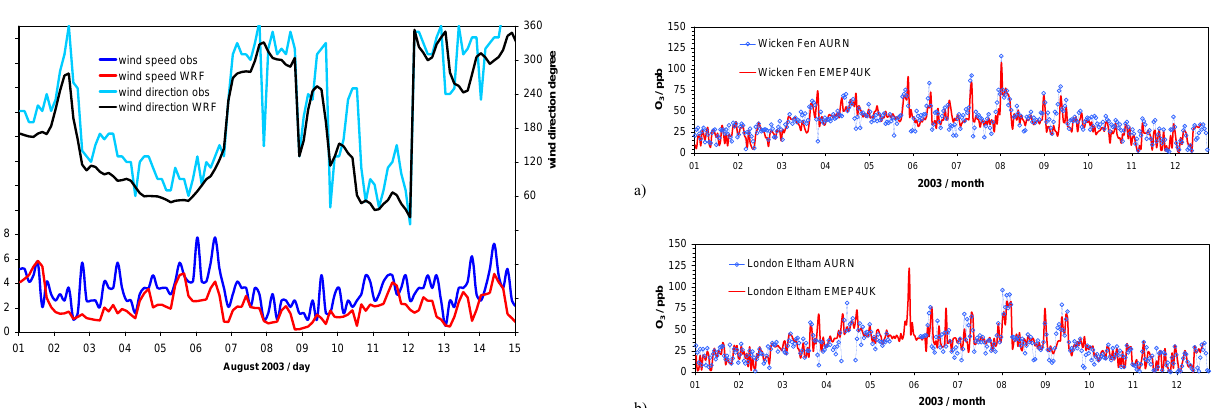
Fig. 2. Time series of hourly modelled (red, black) and observed Figure 2: Time series of hourly modelled (red, black) and observed (blue, pale blue) 10 m (blue, pale blue) 10m wind speed (bottom, ms − 1 ) and 10m wind wind speed (bottom, m s -1 ) and 10 m wind direction (top, degrees) at Wattisham. direction (top, degrees) at Wattisham.